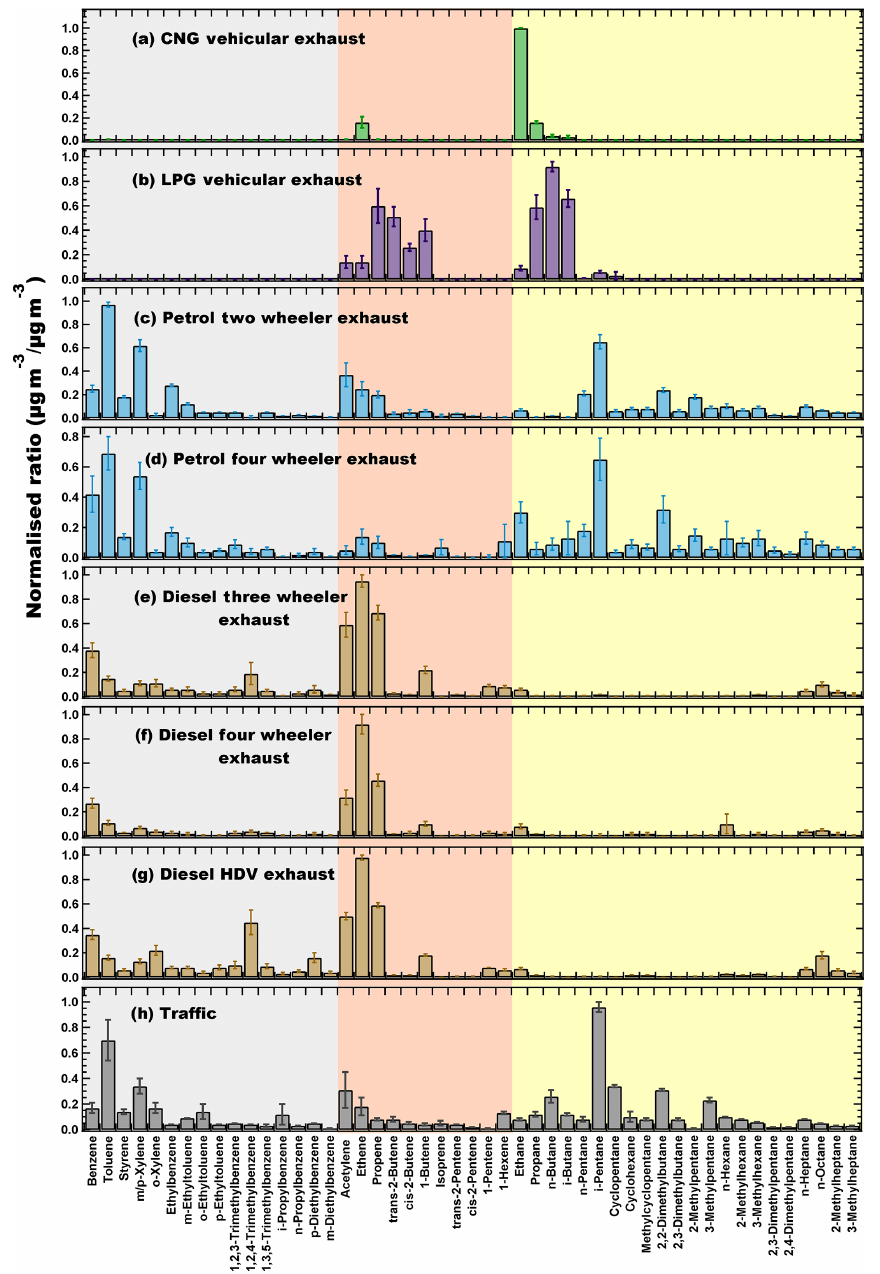
Figure 2. Normalised source profiles of (a) compressed natural gas (CNG) vehicular exhaust, (b) LPG vehicular exhaust, (c) petrol two- wheeler vehicular exhaust, (d) petrol four-wheeler vehicular exhaust, (e) diesel three-wheeler vehicular exhaust, (f) diesel four-wheeler vehicular exhaust, (g) diesel heavy-duty vehicle (HDV) exhaust and (h) traffic derived from the TD-GC-FID measurements. Error bars represent the standard error of averaged normalised ratio. Grey highlights the aromatics, red the alkenes and alkyne and yellow the